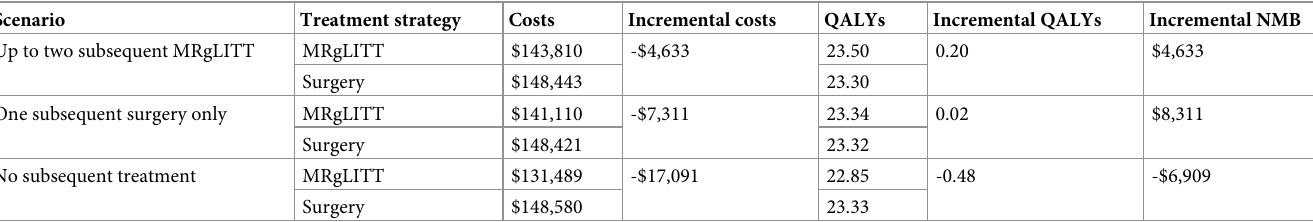
Table 5. Scenario analyses of different subsequent treatment options following an unsuccessful